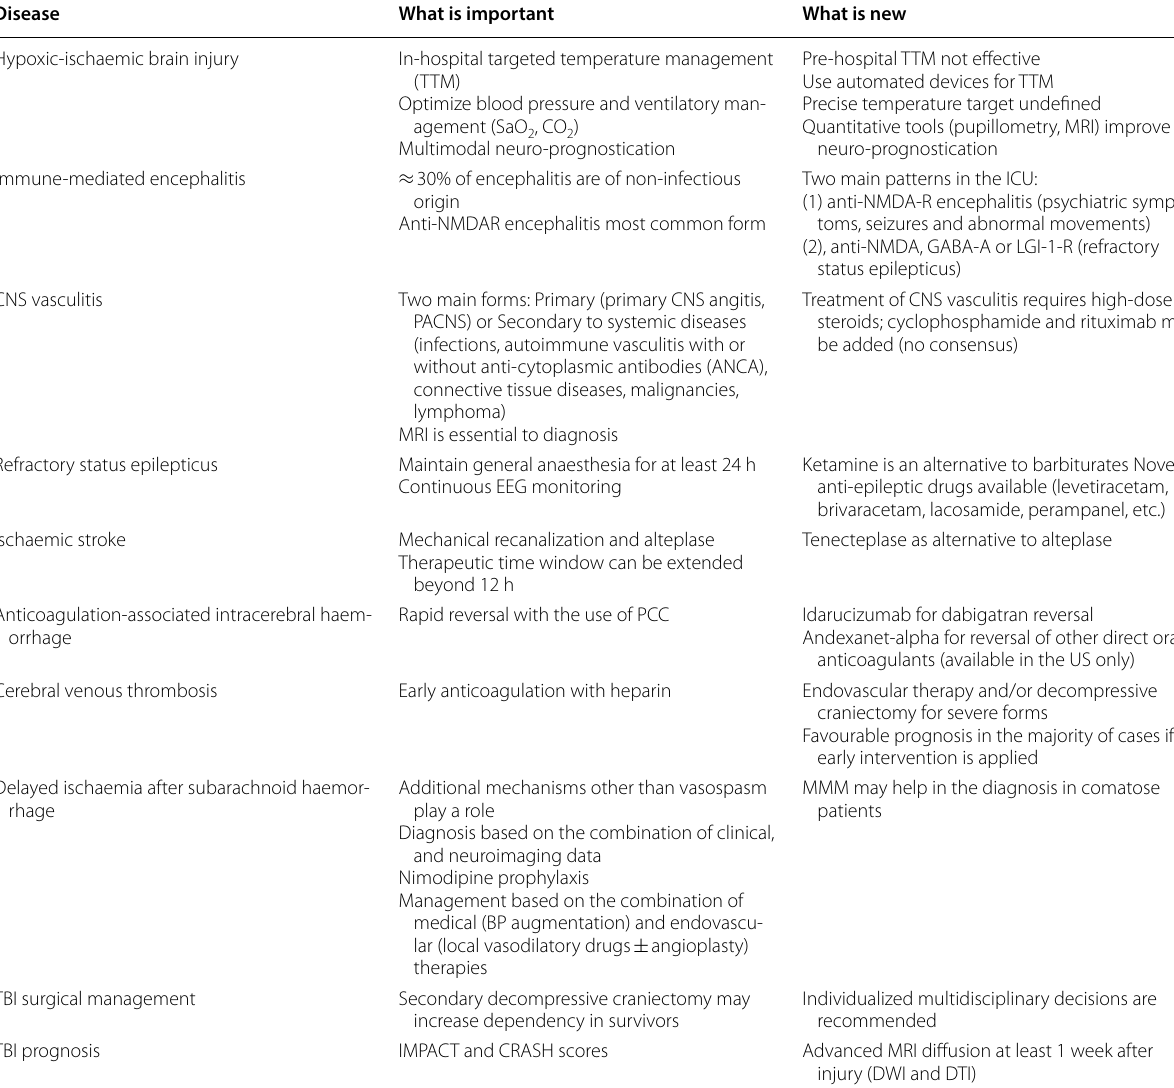
Table 2 Caring for the injured brain: specific management of severe acute cerebral pathologies Disease What is